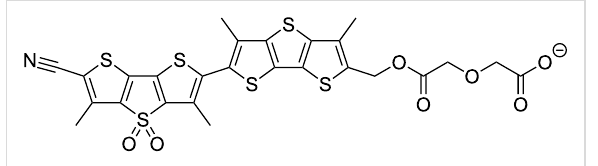
Figure 1: Structure of the (bis)dithienothiophene mechanosensitive flipper probe. Twisted out of planarity by two methyl groups next to the mechanosensitive bond, the two flipper-like heterocycles arrange themselves according to the surface pressure of the membrane.